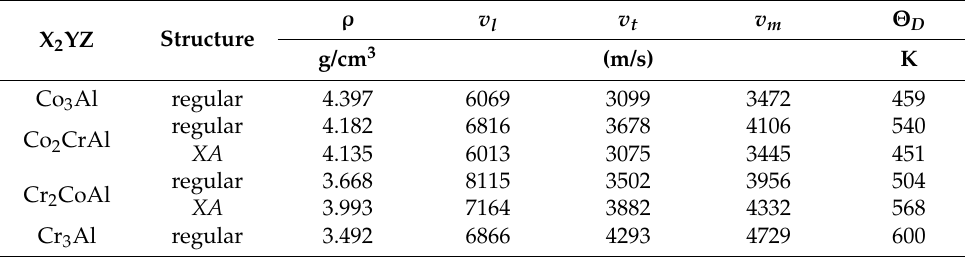
Table 3. The calculated density ρ (g/cm 3 ), longitudinal sound speed v l (m/s), transverse sound speed v t (m/s), average sound speed v m (m/s) and Debye temperature Θ D (K), d from the calculated elastic moduli. X 2 YZ